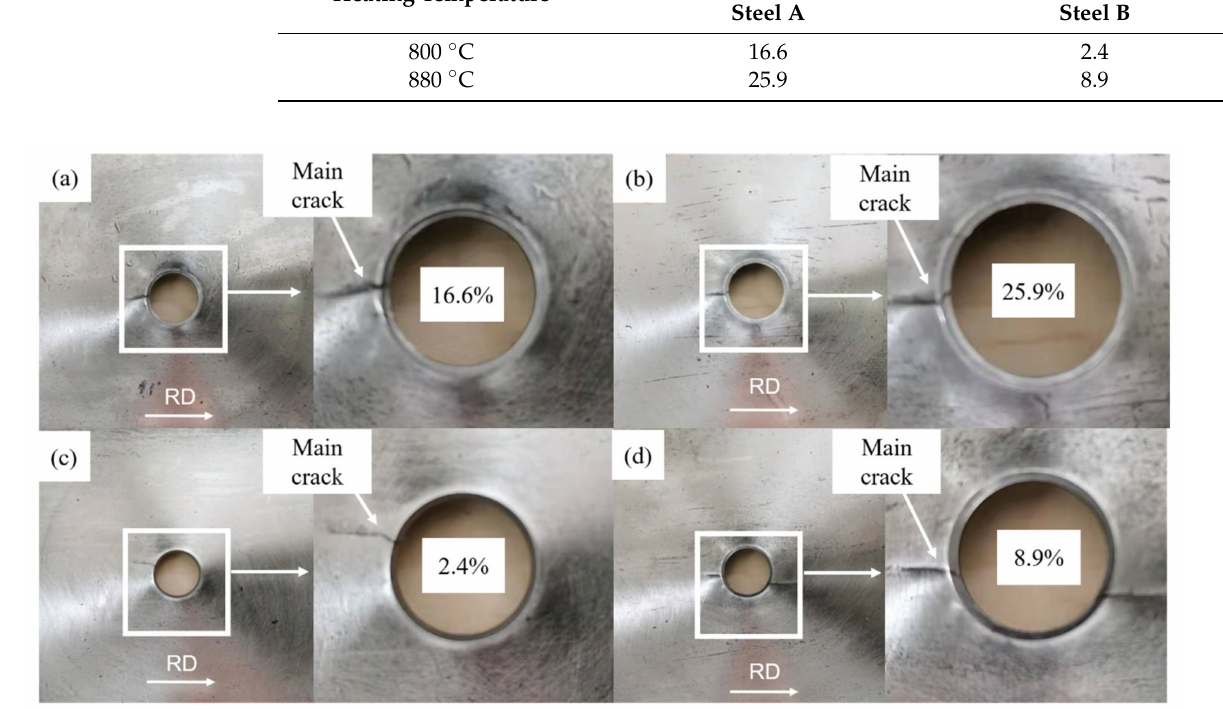
Figure 11. Crack shape in the hole-edge regions after HET of steels A ( a , b ) and steel B ( c , d ), heated at 800 ◦ C and 880 ◦ C for 3 min then air